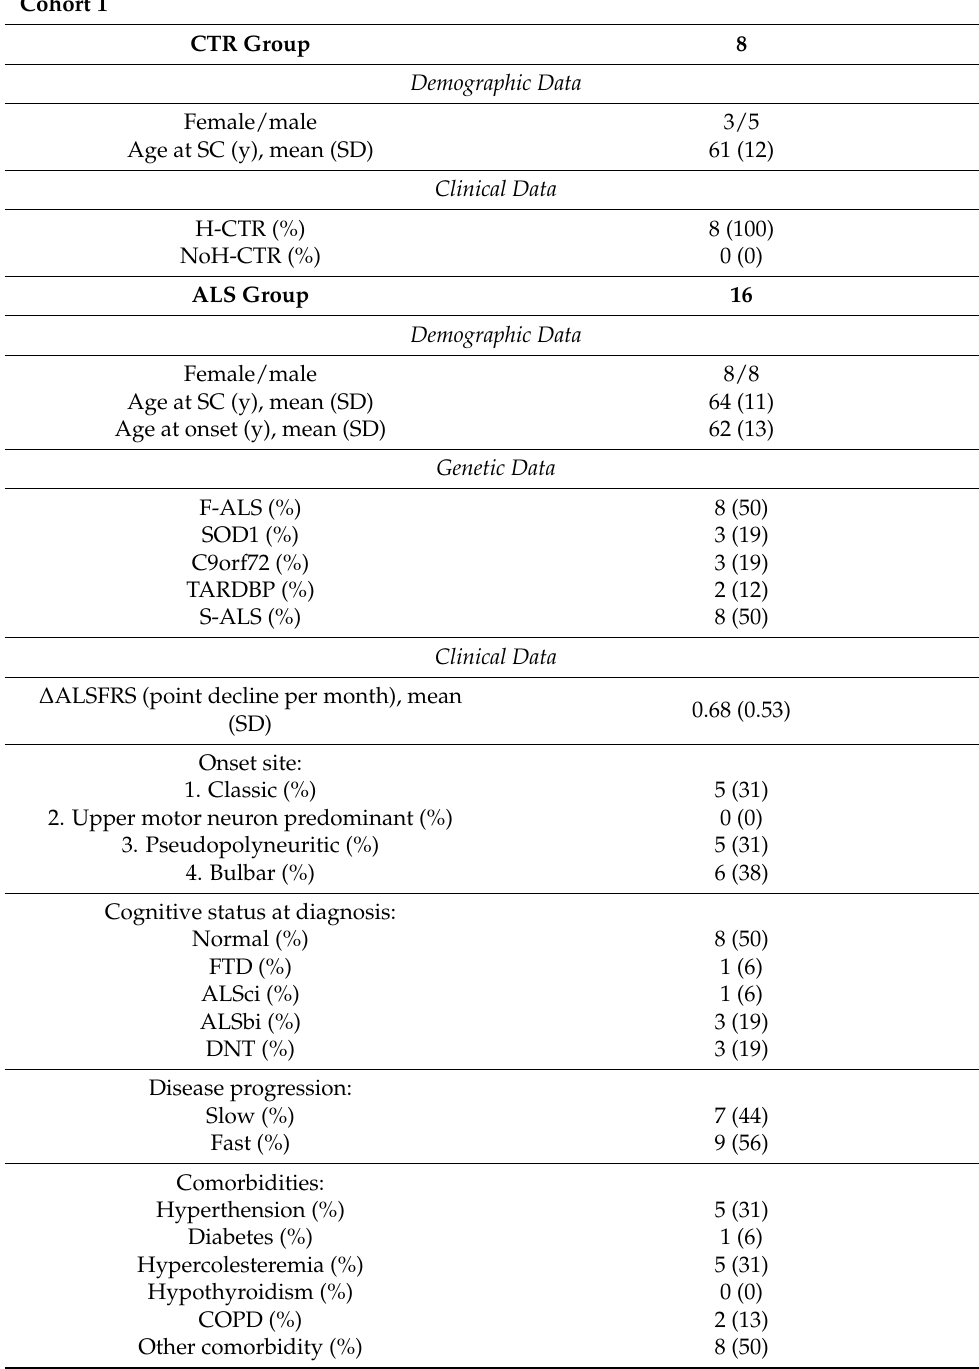
Table 1. Characteristics of control subjects and ALS patients in Cohort 1 for SOMAscan assay and Cohort 2 for protein validation by ELISA. Abbreviations: CTR = control group; H-CTR = healthy control; NoH-CTR = no healthy control; SC = sample collection; y = years; SD = standard deviation; F-ALS = familial ALS patients; C9orf72 = chromosome 9 open reading frame 72; SOD1 = superoxide dismutase 1; TARDBP = TAR DNA binding protein; S-ALS = sporadic ALS pa- tients; FTD-ALS = frontotemporal dementia; ALSci = ALS with cognitive impairment; ALSbi = ALS with behavioral impairment; DNT = data not tested; DNP = data not provided; COPD = chronic obstructive pulmonary